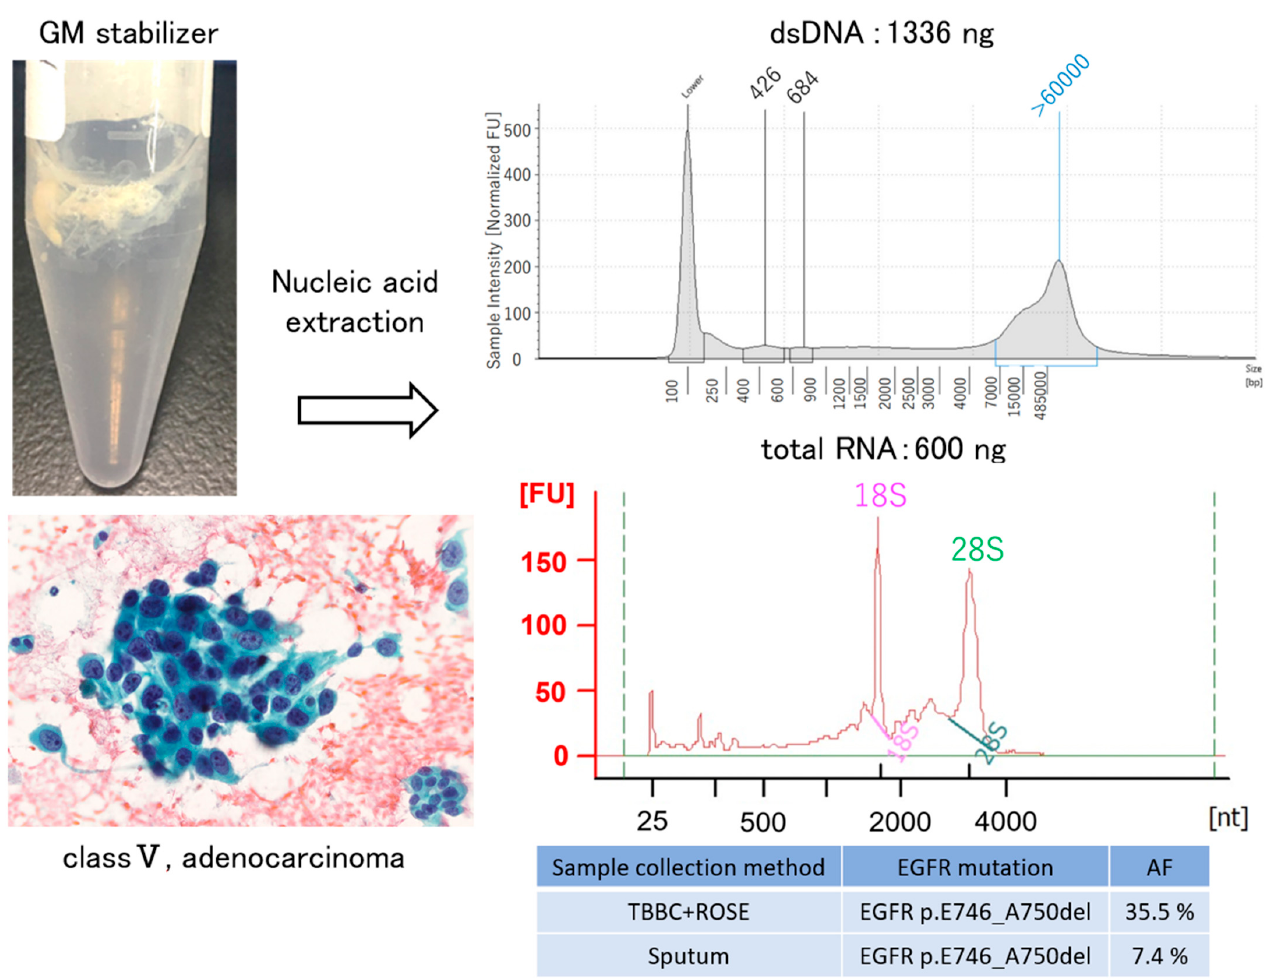
Figure 3. Sputum containing malignant cells was injected into the GM tube, and the nucleic acid was extracted. Sufficient nucleic acid yields were obtained for both DNA and RNA. EGFR activating mutations were also detected, although the AF was lower than bronchoscopic brush samples (case 1). TBBC: transbronchial brushing cytology. ROSE: rapid on-site cytologic evaluation. AF: allele frequency.